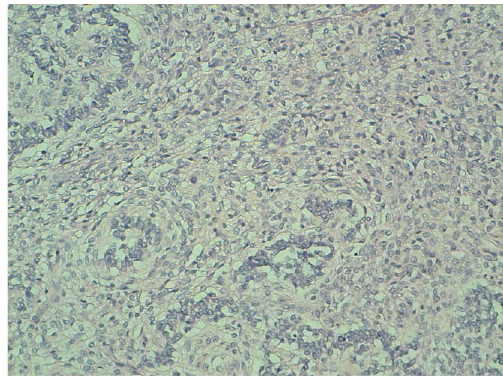
Figure 4: Microscopic finding: immunohistochimy coloration. ESNs like other uterine neoplasms of stromal origin, occur primarily in peri- and postmenopausal women. Tavas- soli and Norris [8, 9] reviewed 60 women with endometrial stromal nodules; the median age was 47 years. The